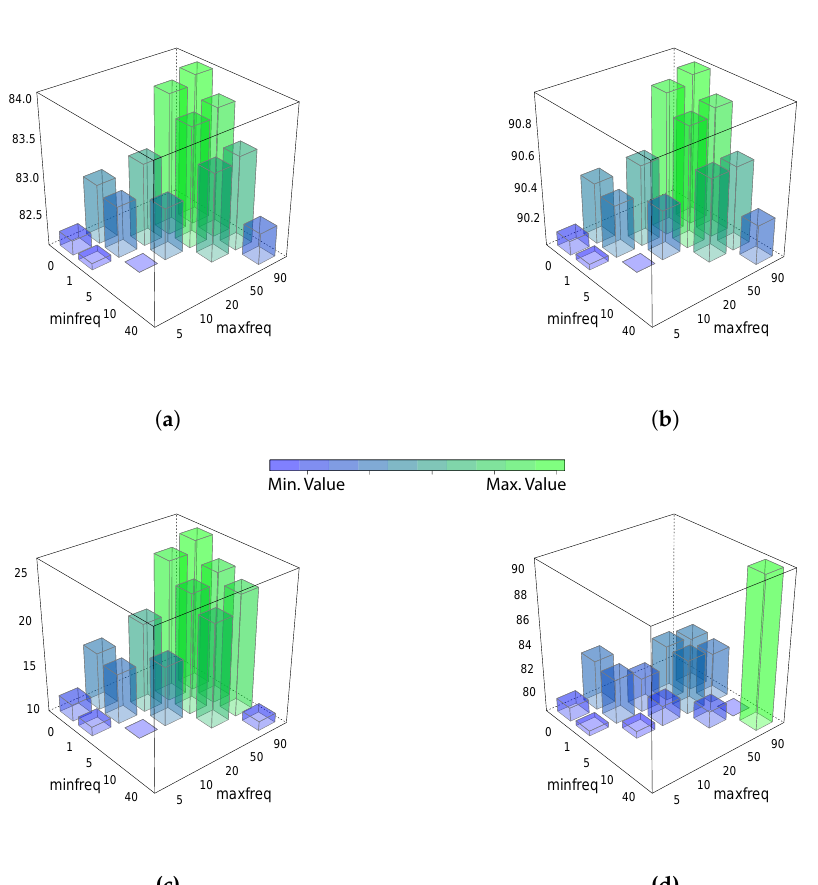
Figure 7. Summary of the results for the gearbox failures using a decision tree model. The vertical axis indicates the minimum frequency % of a word in the training dataset in order to be selected by the model. The horizontal axis indicates the maximum frequency %. Each of the panels show a different metric for the same experiment. ( a ) shows the Accuracy %, ( b ) the F-Score in %, ( c ) the Kappa in % and ( d ) indicates the AUC. Empty blocks (ranges) are values that cannot be calculated are from a predictionwith a unique class